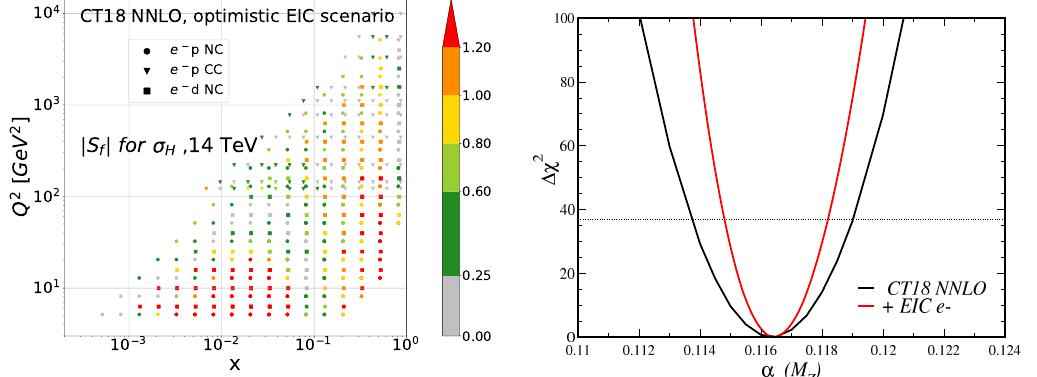
Figure 3: The PDF sensitivity of the 100 fb − 1 EIC pseudodata explored in the EIC Yellow Report translates into a substantial point-by-point impact on the SM Higgs production cross section (left), as visualized using the PDFSense methodology [ 8 ] . Similarly, extensive DIS collisions covering a range of scales and x values results in important potential constraints on the strong coupling, α can improve by ∼ 40% over the corresponding uncertainty in CT18 NNLO following the inclusion and analysis of 100 fb − 1 of electron-scattering data. Both panels are taken from Ref. [ 3 ]